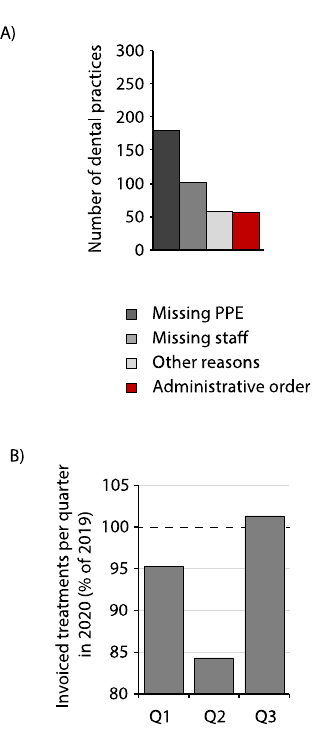
Figure 6. Effects of the COVID-19 pandemic on Bavarian dental practices. ( A ) Reason for temporary closure of dental practices in absolute numbers on 6 April 2020. ( B ) Invoiced treatments of patients insured under a statutory insurance in Bavaria in the quarters Q1–Q3 in 2020 in percent of the same quarters in